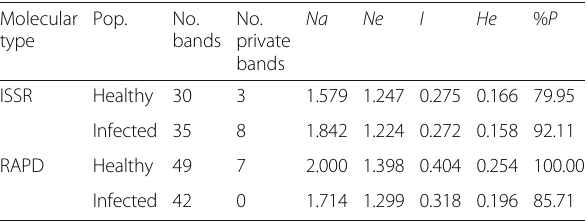
Table 4 Genetic variation statistics revealed through RAPD and ISSR markers comparing the healthy and infected B.